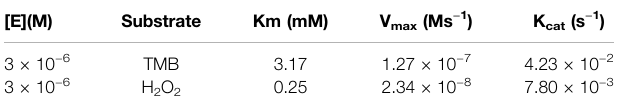
TABLE 2 | Apparent kinetic parameters of CD – TMB – H 2 O 2